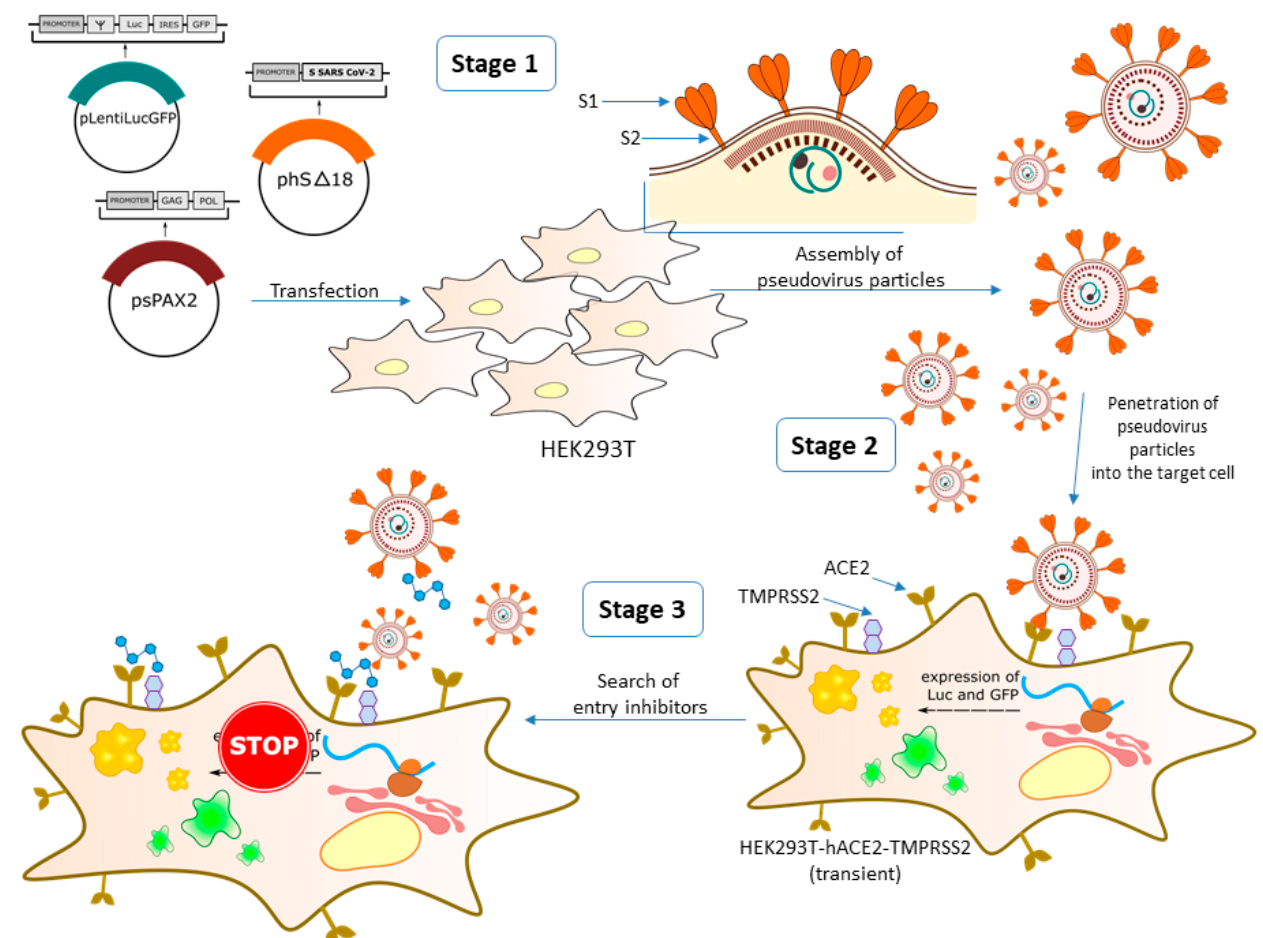
Figure 1. Scheme of work with the pseudovirus system. Experimental work with pseudoviruses includes several stages: Stage ( 1 ) is the assembly of viral particles by transfection of the HEK293 cell line using three plasmids—core, reporter and envelope; Stage ( 2 ) is the determination of the ability of pseudoviral particles to infect target cells; and Stage ( 3 ) is the direct neutralization assay using immune sera or chemotherapeutic agents to determine their ability to block pseudoviruses from entering target cells.